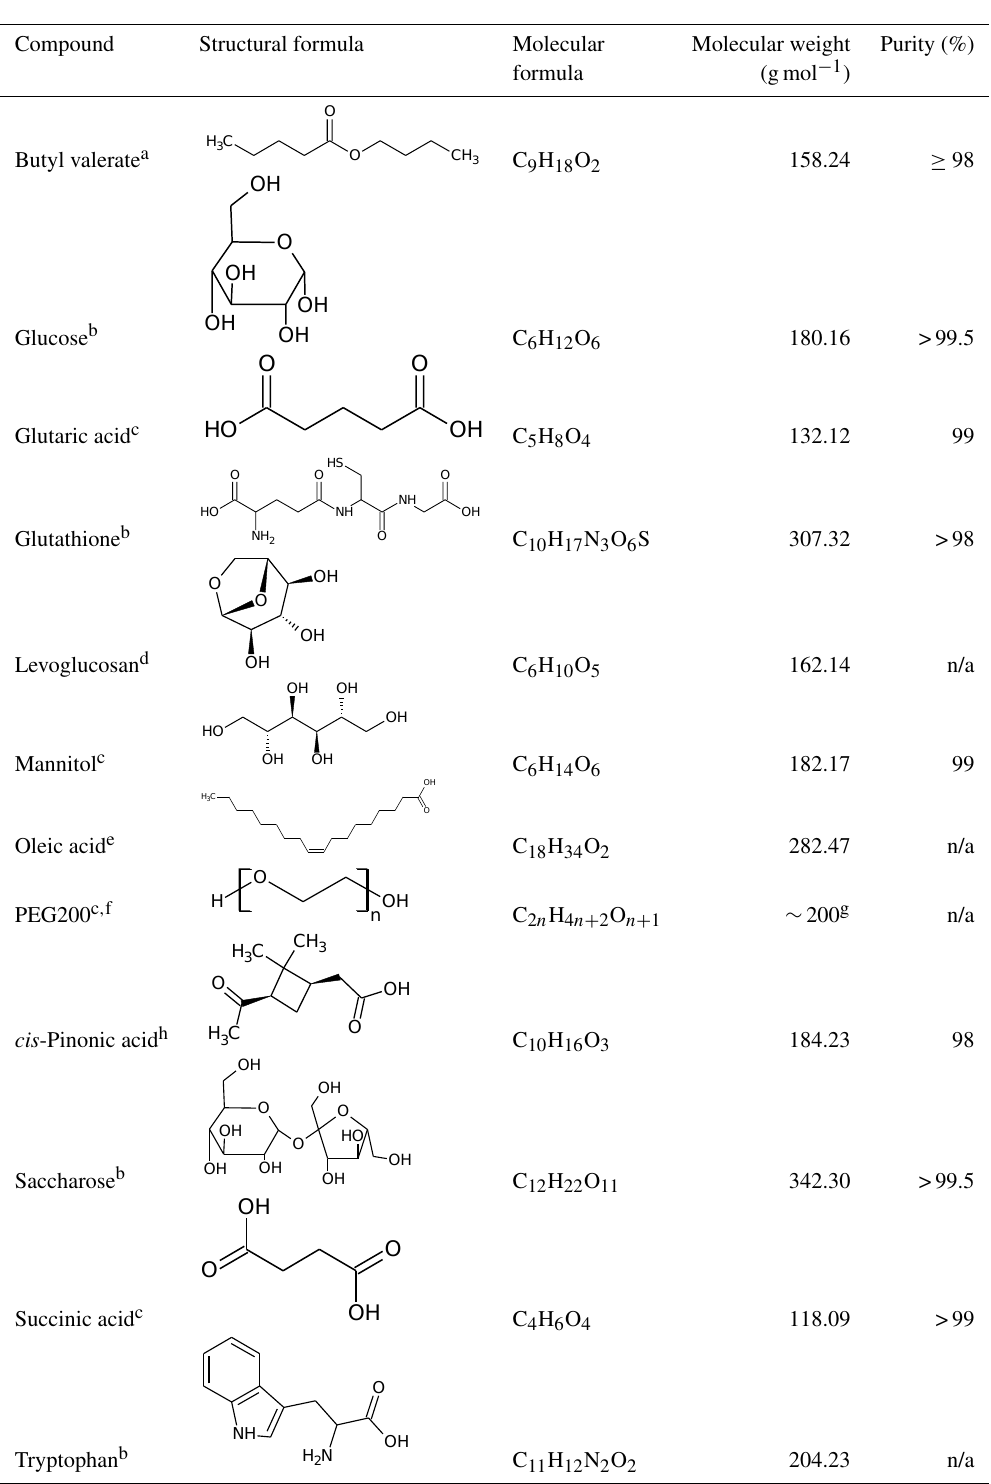
Table 1: Organic substances investigated in the laboratory studies. n/a: not available.